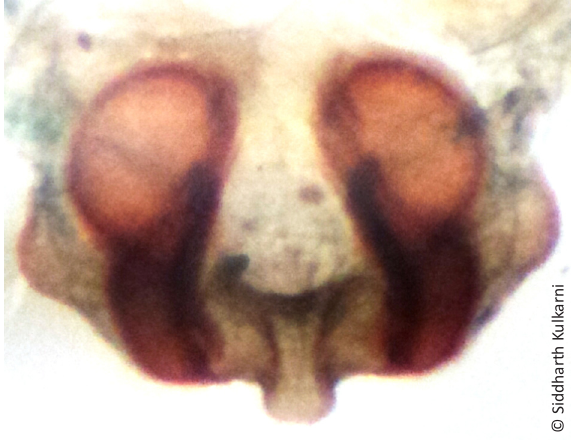
Image 3. Epigyne dorsal